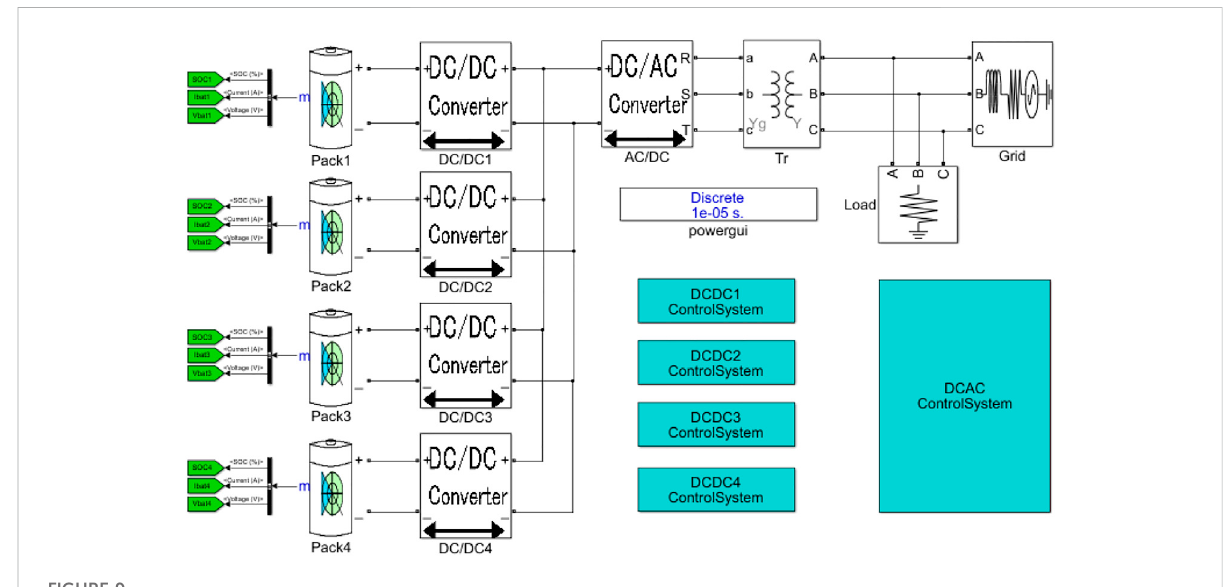
FIGURE 9 Model of the power battery test system.